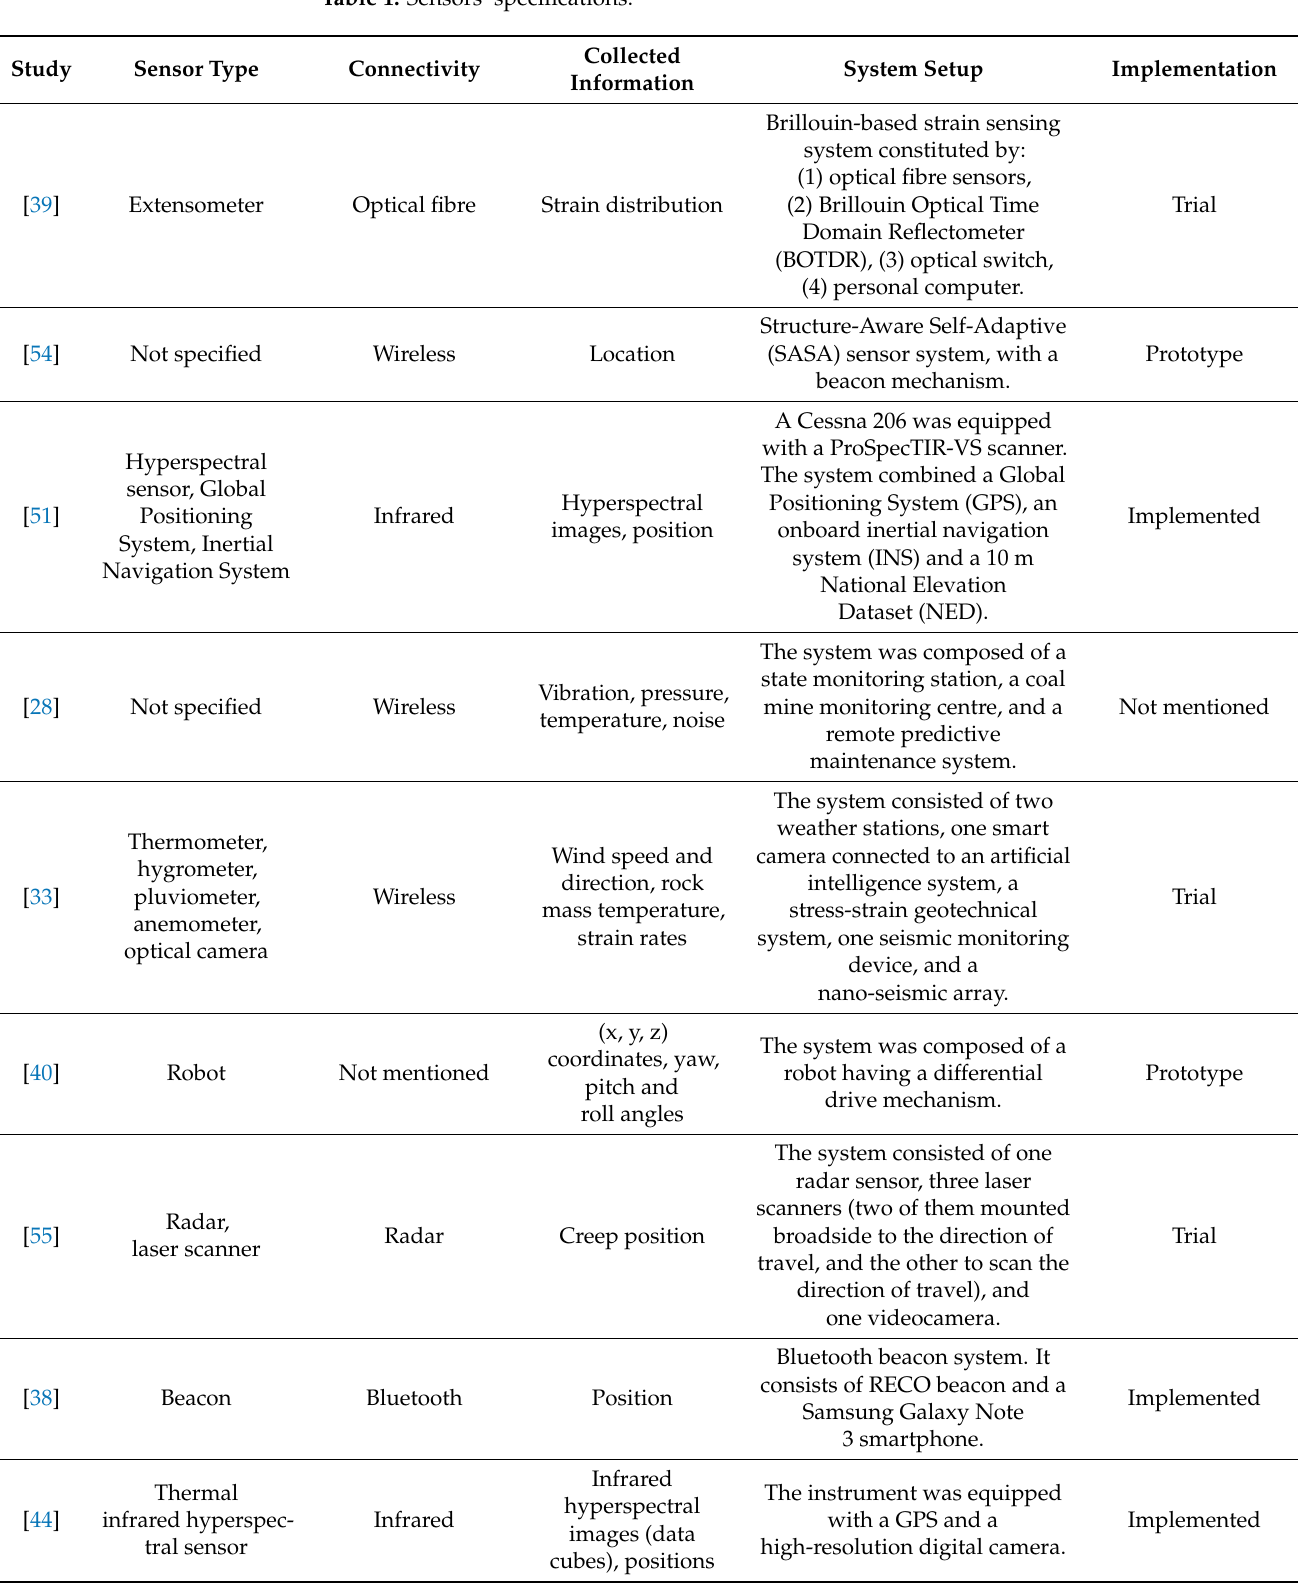
Table 1. Sensors’